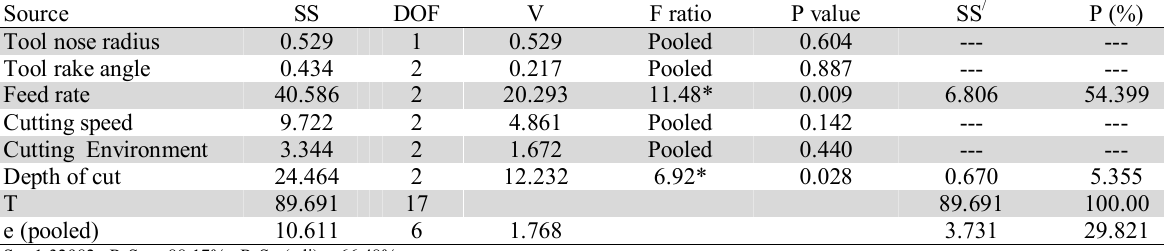
Analysis of Variance for Grey Relational